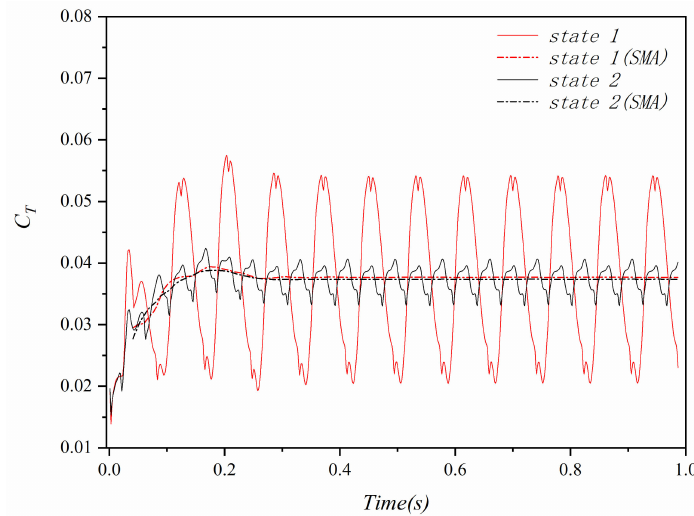
Figure 19. The isolated rotor C T in forward flight.